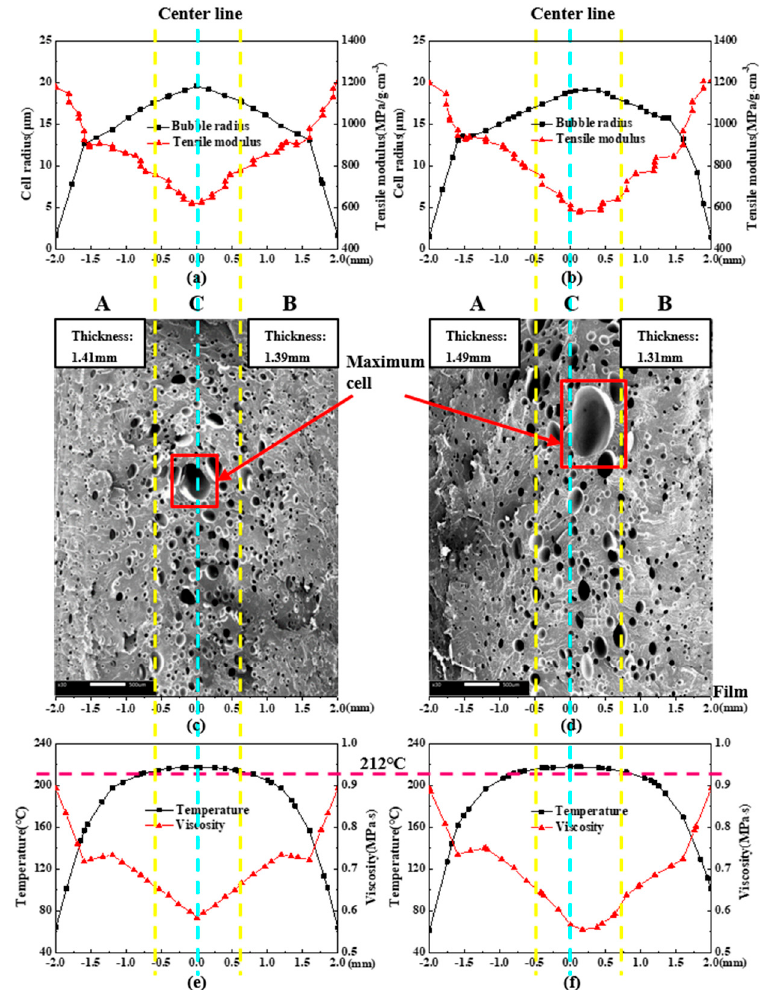
Figure 14. Simulation results and SEM micrographs of the vertical section of MIM and IMD/MIM samples: ( a ), ( b ) and ( e ), ( f ) the simulation results along the center line of vertical section of MIM and IMD/MIM samples, respectively; ( c ) and ( d ) the SEM micrograph of MIM and IMD/MIM samples, respectively.